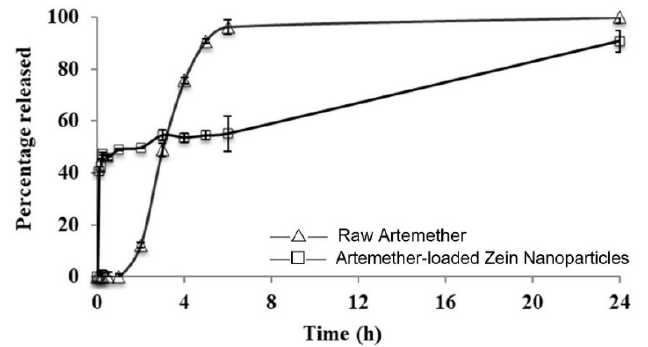
Figure 8. Release profiles of artemether from artemether-loaded zein nanoparticles and raw artemether in phosphate buffer solution (PBS) at 37 ◦ C. All experiments were carried out in triplicate ( n = 3); symbols represent mean values while error bars represent SD.